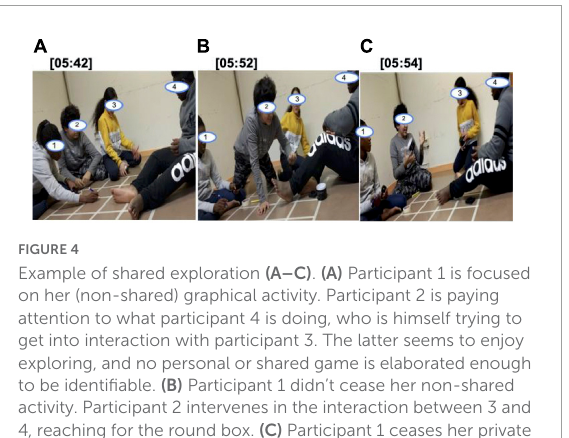
I. In Figure 5A player 4 puts one object on top of the